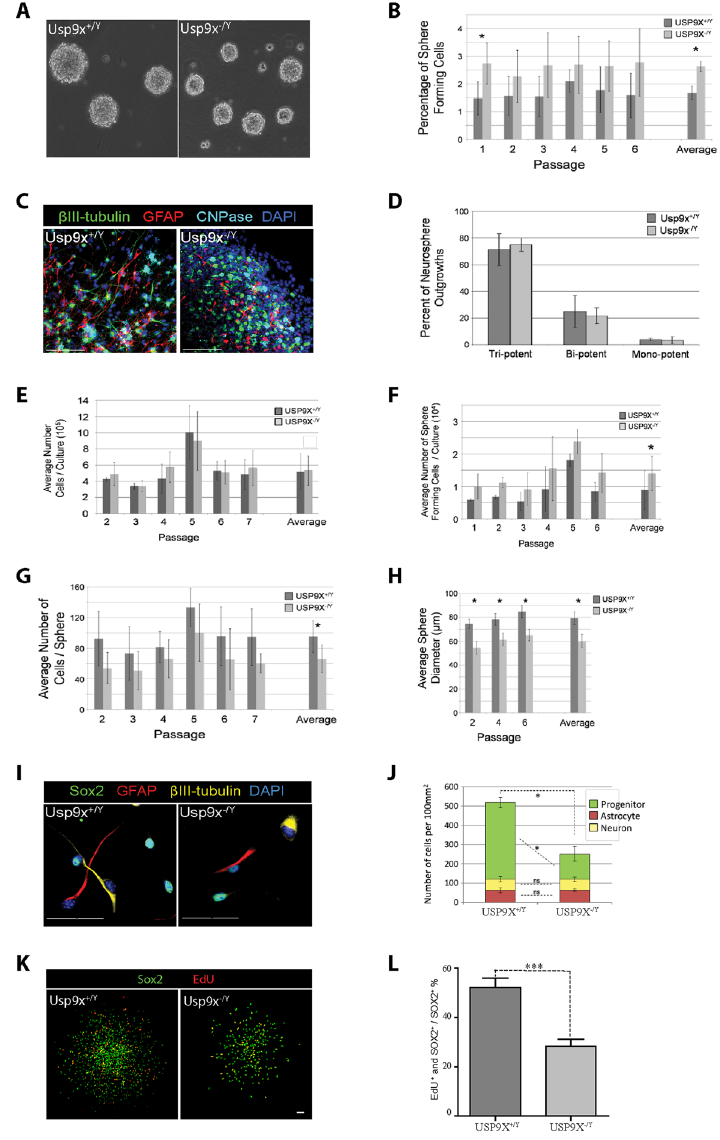
Figure 5. Loss of Usp9x promotes stem-cell self-renewal and loss of bulk NP proliferation. Neurosphere cultures were derived from the cortices of E18.5 Usp9x + /Y (n = 4) and Usp9x − /Y (n = 5) mice. ( A ) Representative phase contrast images Usp9x + /Y and Usp9x − /Y neurospheres. ( B ) Usp9x − /Y cultures contain a higher percentage of sphere-forming cells. The average percentage of cells from dissociated neurospheres, that re-form spheres at very low density, was derived over several passages. ( C , D ) Loss of Usp9x does not affect the multipotency of sphere-forming cells. Whole neurospheres (passage 2, n = 3 for Usp9x − /Y and Usp9x − /Y ) were plated at low density and outgrowths stained and scored after 6 days. ( C ) Representative image of cultures labelled for cell type marker proteins GFAP: astrocytes; β III-tubulin: neurons and CNPase: oliogodendrocytes. ( D ) The percentage of neurosphere outgrowths displaying tri - bi and mono-potency scored and compared by Student t-test (not statistically different). ( E ) Usp9x + /Y and Usp9x − /Y cultures contain equivalent number of cells at each passage. ( F ) Usp9x − / y cultures contain increased numbers of sphere forming cells. Total sphere- forming cells calculated across several passages. ( G , H ) Usp9x − /Y neurospheres are smaller. Mean diameter and number of cells per neurosphere at each passage. ( I , J ) Loss of Usp9x decreases NP number. Neurosphere cultures (passage 2, n = 3 for Usp9x − /Y and Usp9x − /Y ) were dissociated and plated at very low density onto poly- l-lysine coated plates in media containing EGF and cultures fixed 24 hours later. ( I ) Representative image of immunofluorescently stained cultures; cells labelled for cell markers; Sox2: NP; GFAP: astrocytes; β III-tubulin: neurons. Cell nuclei counterstained with DAPI. ( J ) Cell counts used to quantify numbers of cell types present in cultures. ( K , L ) Loss of Usp9x inhibits NP cell proliferation. ( K ) Representative images of neurospheres allowed to attach for 2 hours followed by a 6 hour EdU pulse and immunostained for the NP marker Sox2 (Green) and EdU (Red). ( L ) Lower percentage of Usp9x − / Y NPs (Sox2-positive) were labelled with EdU indicating diminished NP proliferation. Scale bar = 50 μ m. All data are shown as the means ± SEM. Statistical significance was assessed by the unpaired Student’s t test. * p < 0.05; *** p <